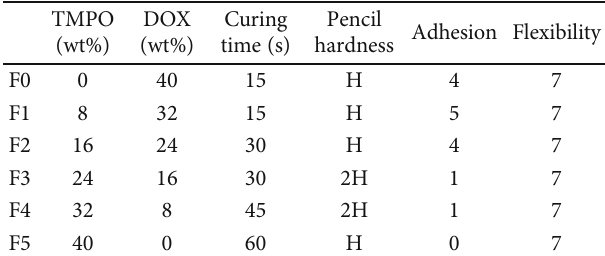
Table 3: E ff ect of the oxetane ratio on the mechanical properties